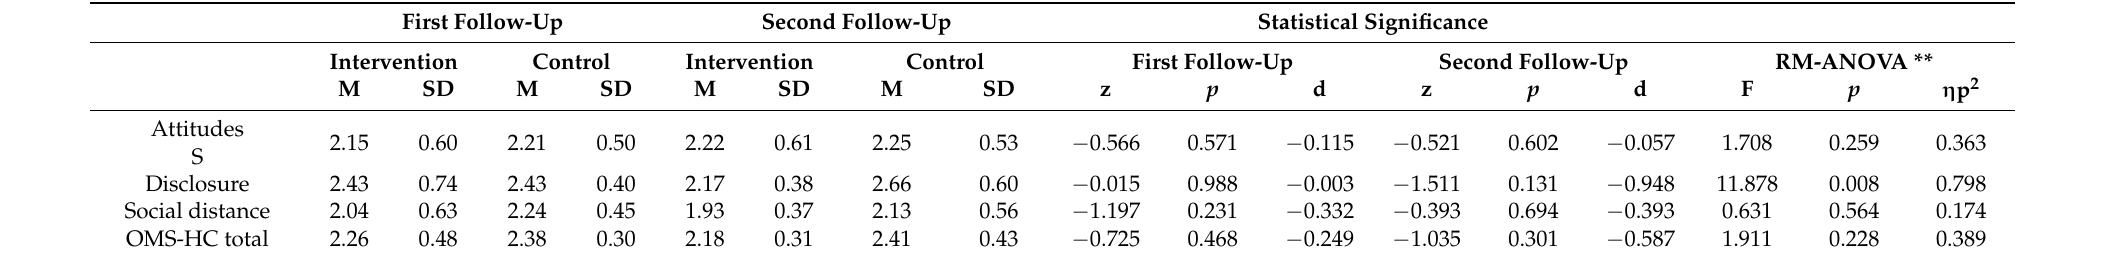
Table 2. Follow-up scores among primary care participants (raw data